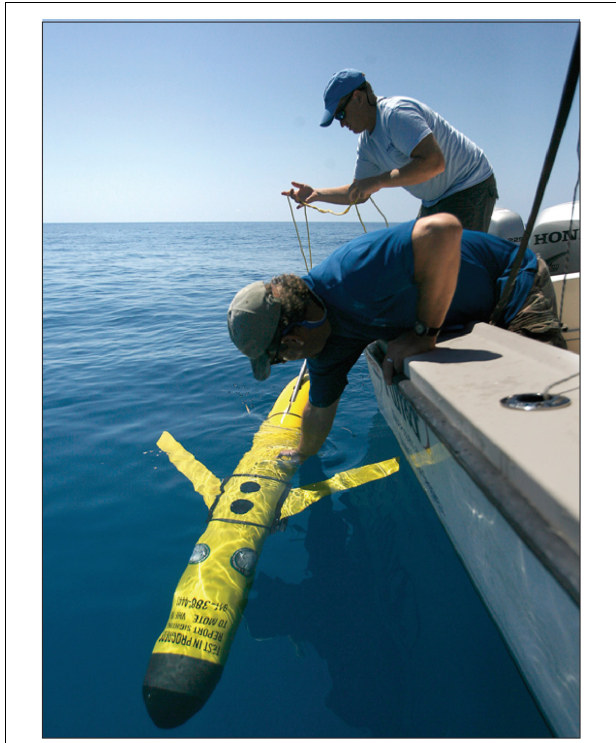
FIGURE 3 | Mote Marine Laboratory scientists deploy a Slocum glider, an autonomous underwater vehicle (AUV), for harmful algal bloom research on the West Florida Shelf. Photo courtesy of Mote Marine